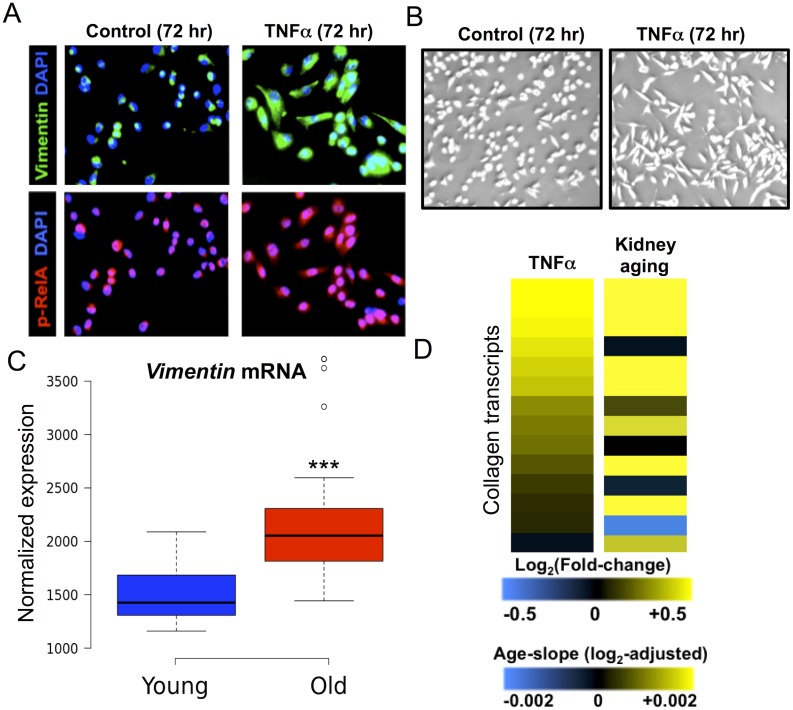
TNFα induces a mesenchymal transition and fibrogenic gene expression in HK-2 cells.A. Immunofluorescence images of HK-2 cells treated with vehicle control (left) or TNFα (right); Cells were co-stained with anti-vimentin antibodies (green, top panels) and pRelA antibodies (red, bottom panels). Increased nuclear pRelA staining in TNFα-treated cells indicates NFκB activation. Induction of vimentin in TNFα-stimulated cells marks the cell fate transition to a mesenchymal-like phenotype. B. Micrograph of HK-2 cells treated with vehicle control (left) or TNFα (right). The TNFα-stimulated cells display an elongated fibroblastic morphology, characteristic of mesenchymal cells. C. The boxplot shows significantly increased levels of vimentin mRNA expression during kidney aging, using expression data from Rodwell et al. 2004. D. Collagen genes are induced by TNFα stimulation and tend to increase expression during aging. The left column of the heat map shows the log2-fold-changes in expression of 14 collagen transcripts following stimulation of HK-2 cells with TNFα. The right column of the heat map shows the age-related slope for these genes during kidney aging.